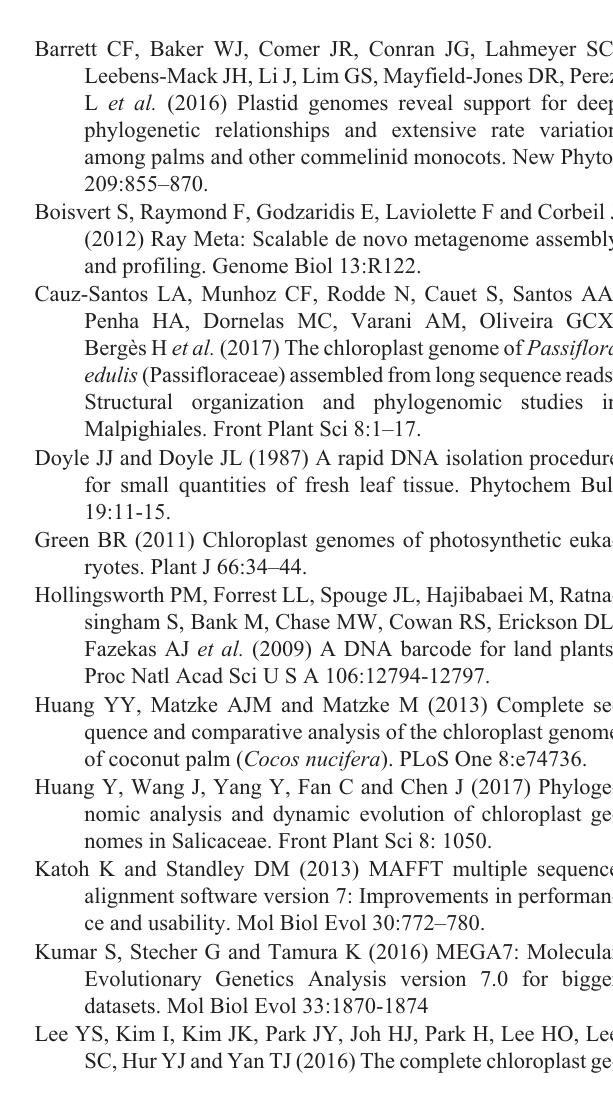
Figure 3 - Molecular phylogenetic analysis by maximum likelihood method, with supported values estimated by